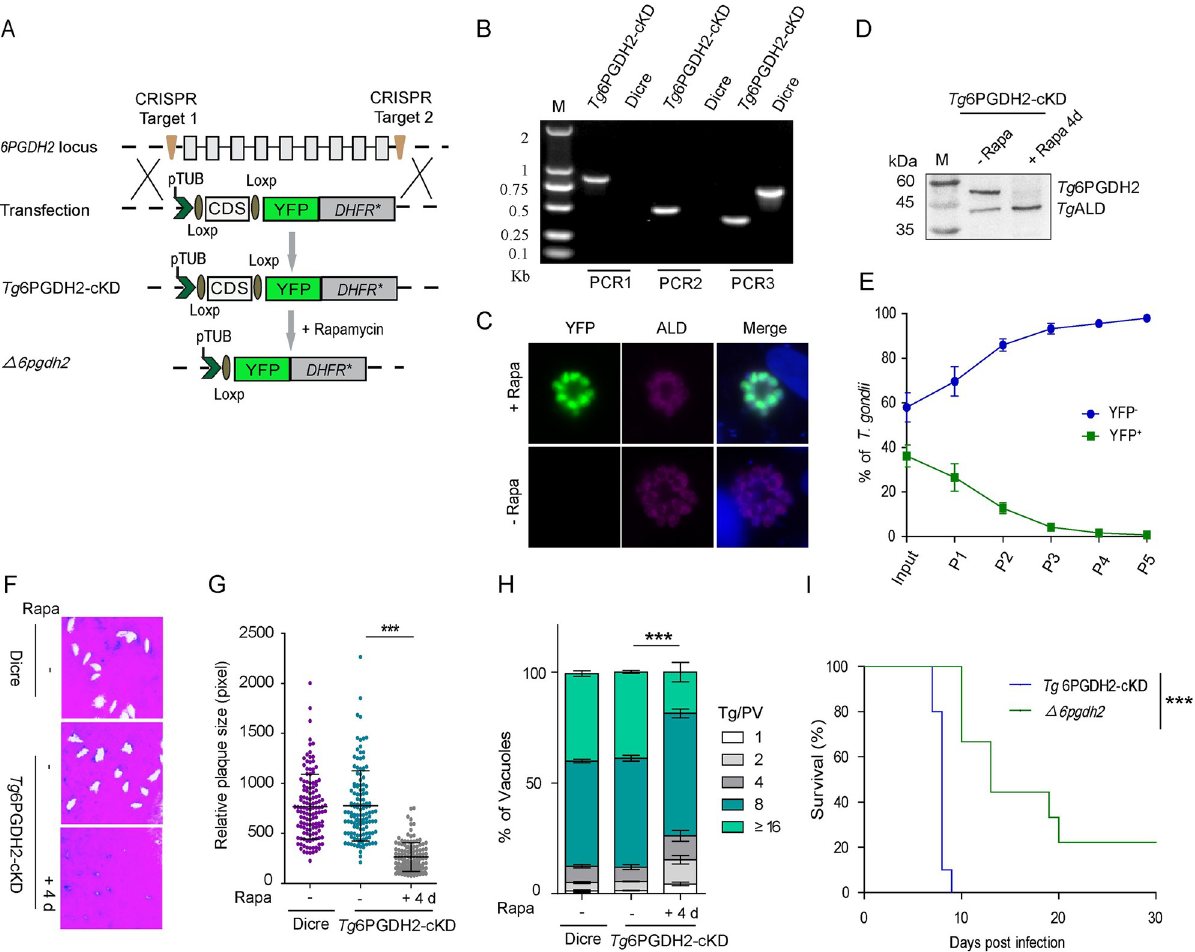
Fig 3. Tg 6PGDH2 is important for parasite survival. (A) , Diagram showing strategy to construct the conditional knockout strain Tg 6PGDH2-cKD, using the LoxP- Cre system in the DiCre strain. (B) , Diagnostic PCRs on a representative Tg 6PGDH2-cKD clone. PCR1 and PCR2 examined the integration of homology templates at the 5 ’ and 3 ’ end of Tg6PGDH2 , whereas PCR3 confirmed the deletion of the endogenous Tg6PGDH2 locus. (C) , Immunofluorescence staining for Tg ALD and YFP expression in Tg 6PGDH2-cKD parasites treated with rapamycin for 2 d. (D) , Western blotting for checking the expression of Tg 6PGDH2 in Tg 6PGDH2-cKD parasites treated with or without rapamycin for 4 days. Tg ALD was included as a loading control. (E) , Competition assay comparing the growth of Tg 6PGDH2-cKD parasites treated with rapamycin for 24 h to that of untreated parasites. (F) , Plaque assay showing the defect in the Tg 6PGDH2-cKD parasites after 4 days of rapamycin treatment. (G) , Tg 6PGDH2-cKD parasites pretreated for 4 days formed smaller plaques than their parental strain, and untreated Tg 6PGDH2-cKD parasites formed plaques similarly to DiCre. (H) , Intracellular replication assay comparing parasite growth in vitro . Tg 6PGDH2-cKD parasites were treated with rapamycin for 4 days, and then they were allowed to infect fresh HFF cells and grown for 24 h, subsequently, the number of parasites in each PV was checked by IFA. Results are means ± SEM for n = 3 independent experiments. (I) , Survival curves of mice infected with tachyzoites of indicated strains. Tg 6PGDH2-cKD and Δ 6pgdh2 mutants were used to infect ICR mice (100 parasites/mouse, n = 10 mice for each strain) by intraperitoneal injection, and the survival of mice was followed for 30 days. � , p < 0 . 05 , Gehan–Breslow–Wilcoxon